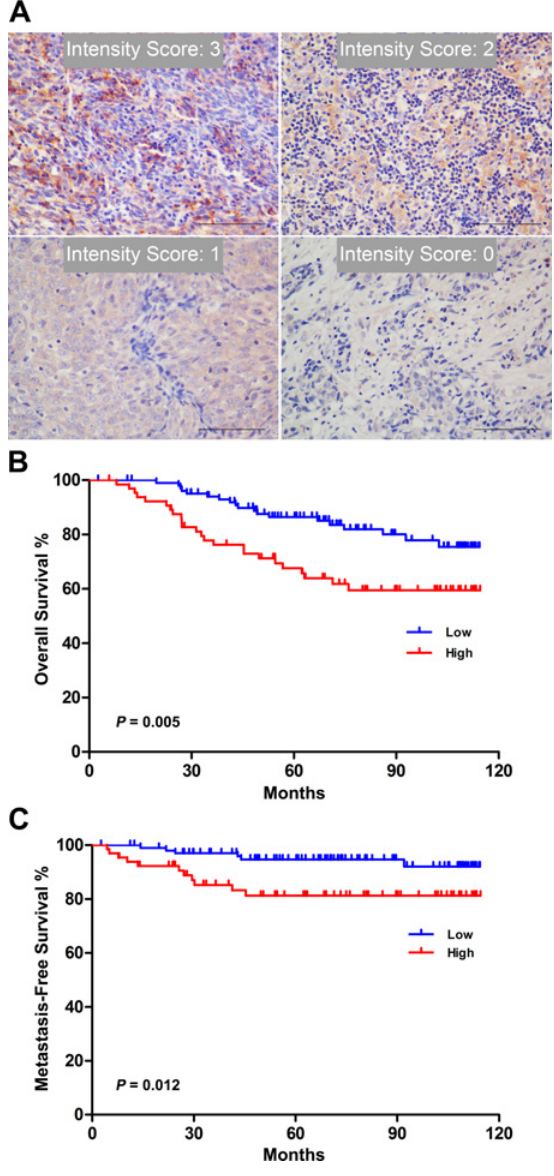
Fig 2. Elevated KLHDC4 expression correlates with poor prognosis in NPC patients. (A) Criteria for scoring of KLHDC4 expression intensity. Representative images are shown. All images were obtained and processed under identical conditions. Scale bars: 100 μ m. (B-C) Kaplan-Meier analysis of KLHDC4 expression and overall survival (B) and metastasis-free survival rate (C) of NPC